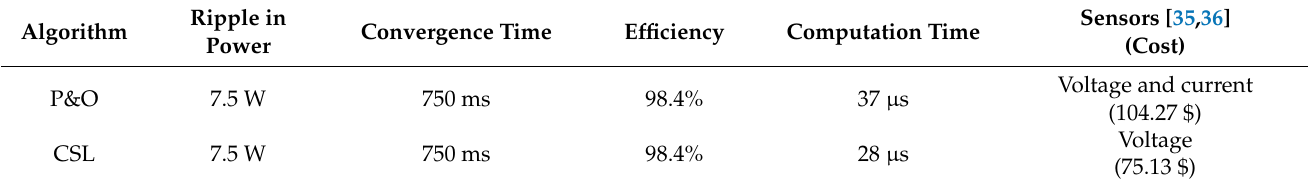
Table 4. Performance comparison between the proposed CSL and conventional P&O